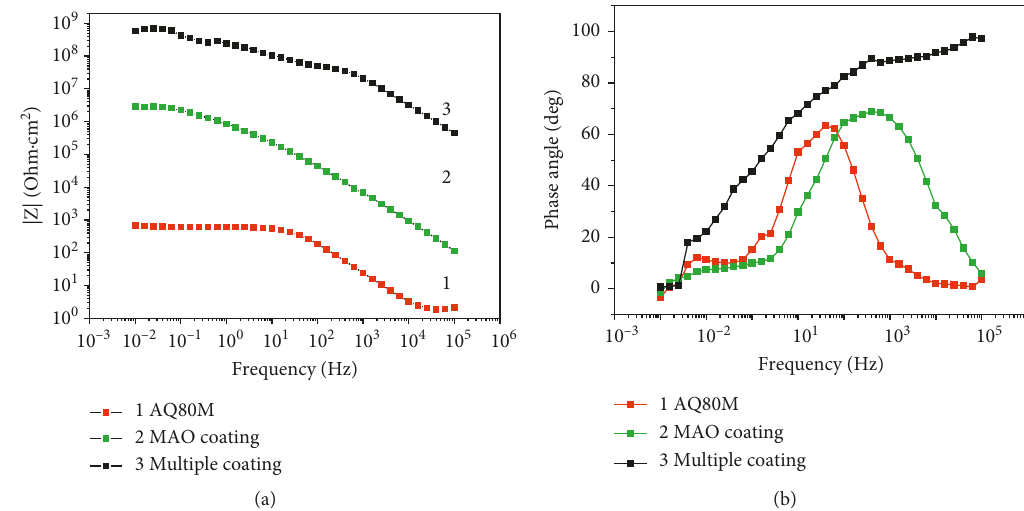
Figure 3: EIS results of the uncoated AQ80M Mg alloy, MAO coating, and multiple